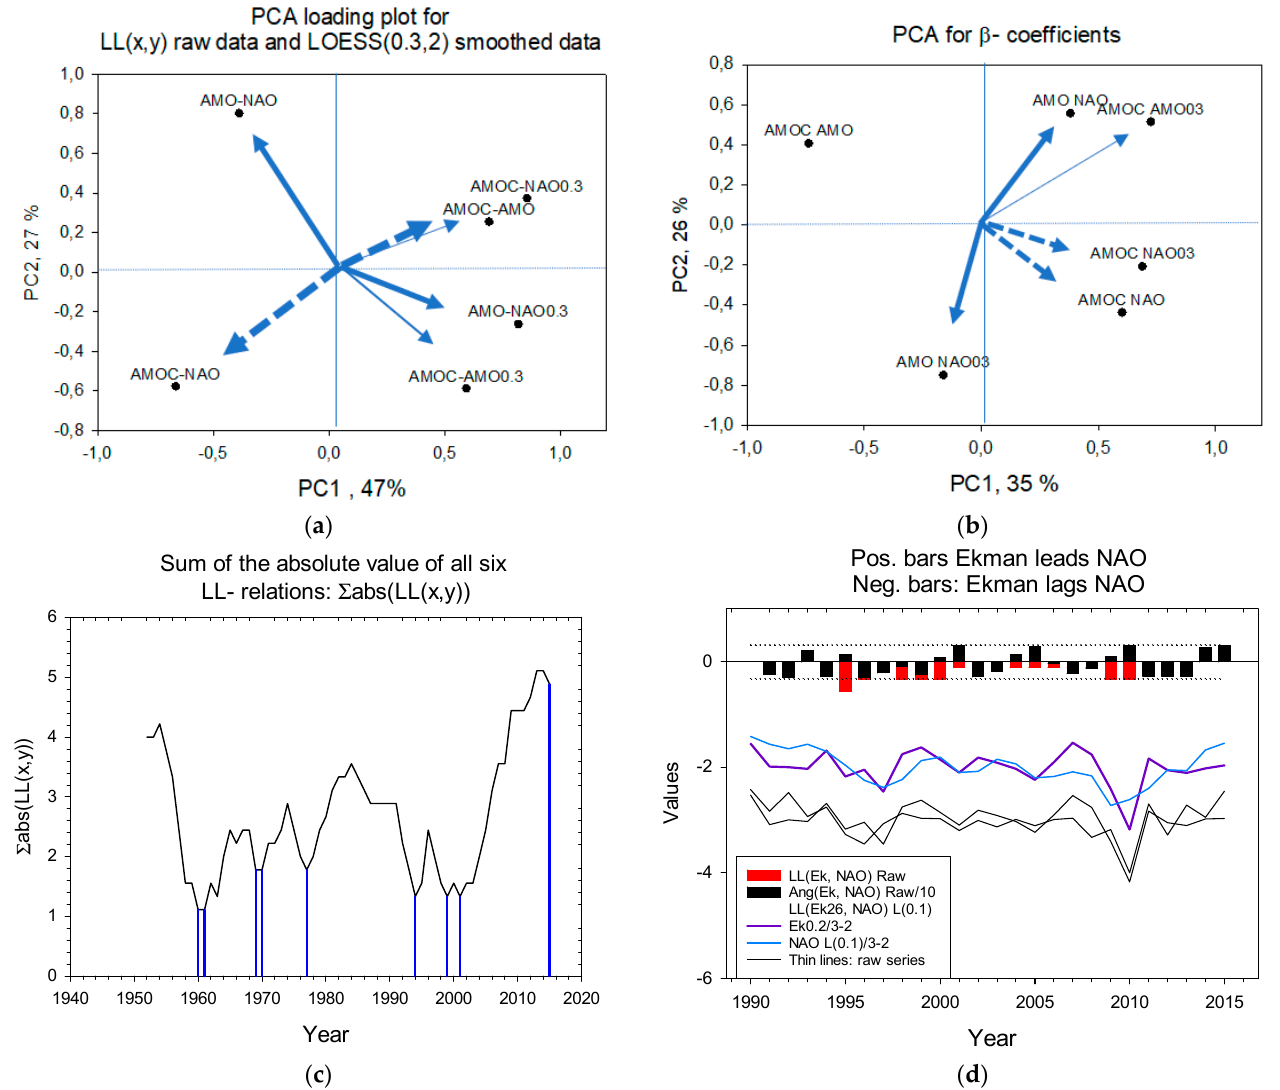
Figure 6. Summary characteristics. ( a ) Principal component loading plot for LL relations between the three modes, AMOC, AMO, and NAO, their high- and low-frequency series. ( b ) PCA loading plot for the series β -coefficients (slopes between paired series), their high- and low-frequency components. ( c ) The stacked sum of the absolute value of the LL (x,y) values. The droplines designate troughs in 1960–1961, 1968–1969, 1977, 1994, and 1999–2001. ( d ) Ekman time series, raw series (dashed lines) and Ekman 26 , LOESS (0.2)-smoothed, and NAO LOESS(0.1)-smoothed (Full lines). The red bars show LL relations based on the raw data, and the light blue bars show LL relations based on LOESS-smoothed series.